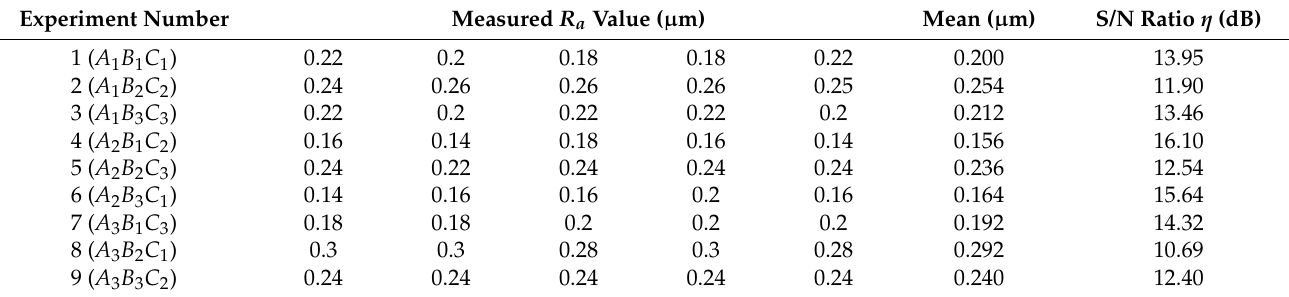
Table 14. Measured values, means, and S/N ratios for surface roughness.